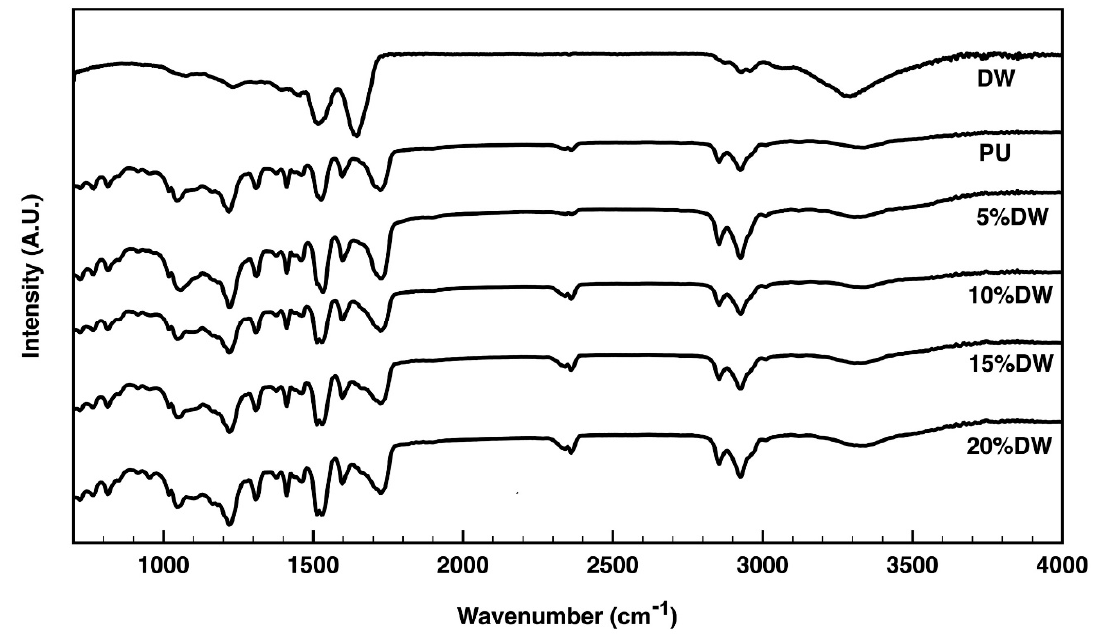
Figure 4. ATR-FTIR spectra of the pristine PU and Dog Wool (DW) and of the eco-composites containing 5% to 20% of dog wool microparticles.